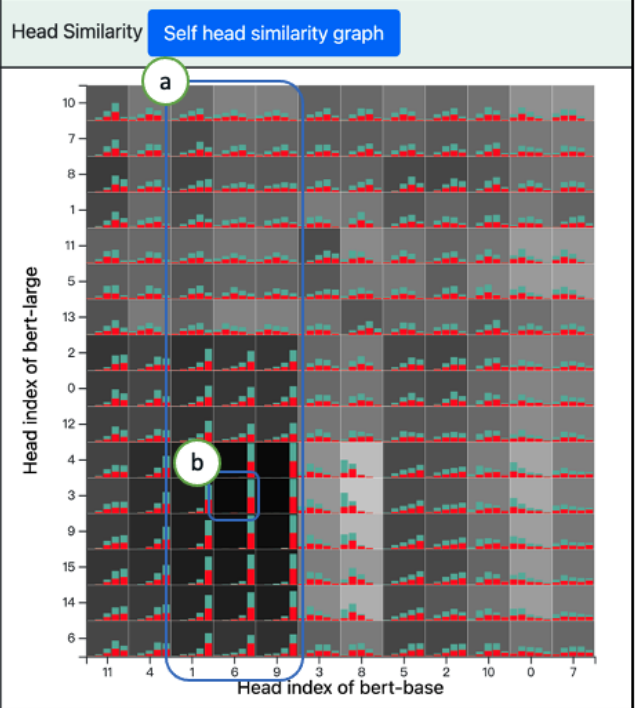
Figure 7. Head similarity graph. After clicking a layer combination in the layer similarity graph, this graph will be shown. The graph shows the similarity for all head combinations and the similarity distribution of instances. The color represents the ground truth label of